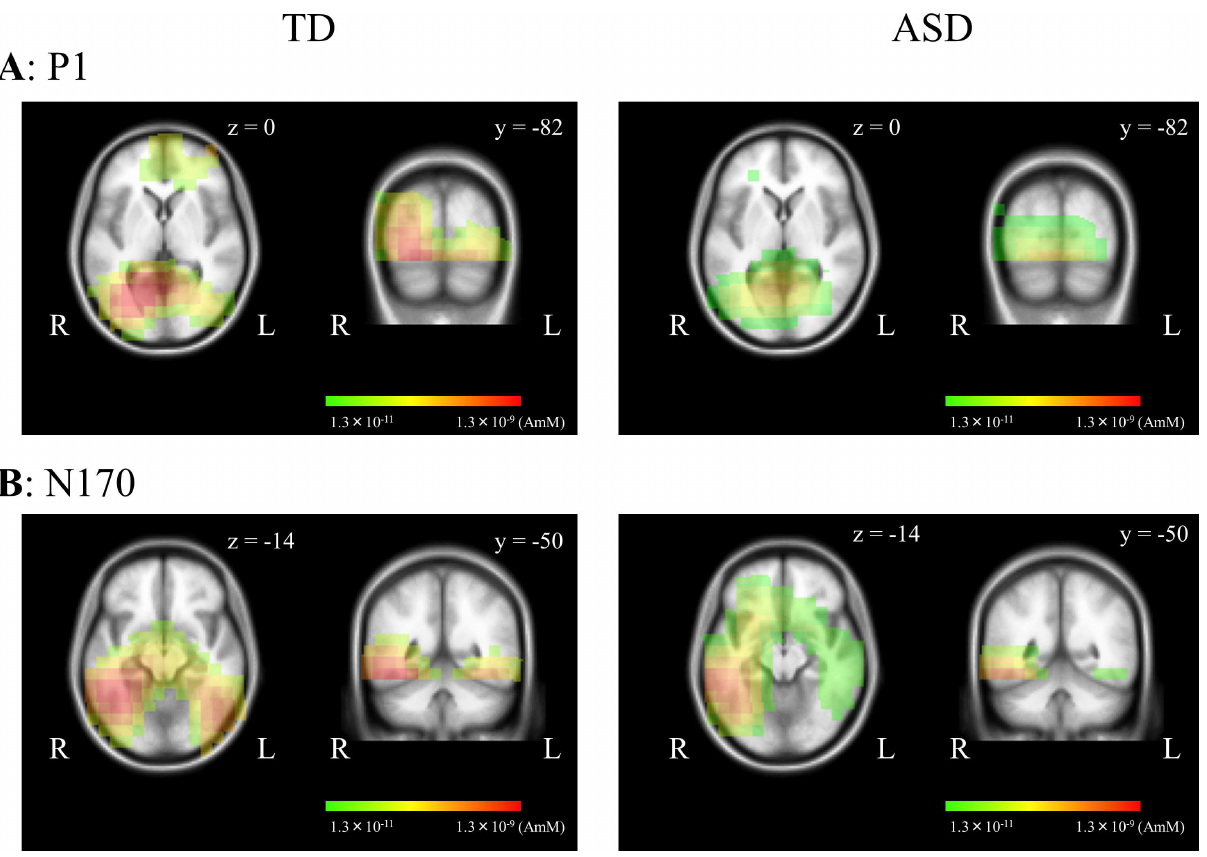
Fig 6. Source analysis for VEPs with face stimuli in each group. sLORETA activities were mappedonto the MNI space. P1 (A) and N170 (B) components for neutral face stimuli were located at aroundoccipitalareas including V1 and occipitotemporal areas includingV4, respectively, in both groups.